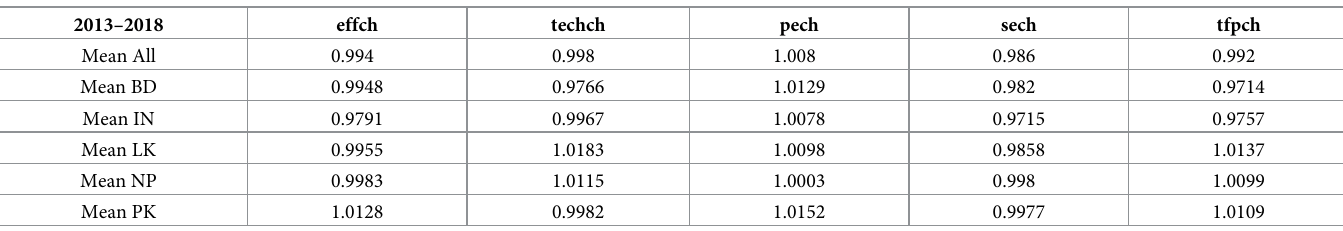
Table 8. Productivity change of each country’s CBs (2013–2018).